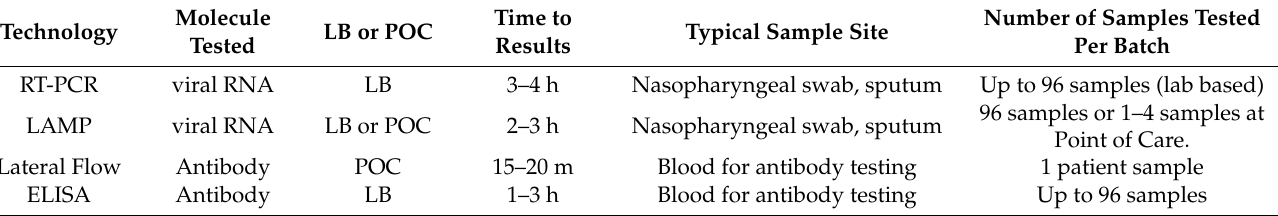
Table 5. Profiles of different diagnostic tests and their advantages and